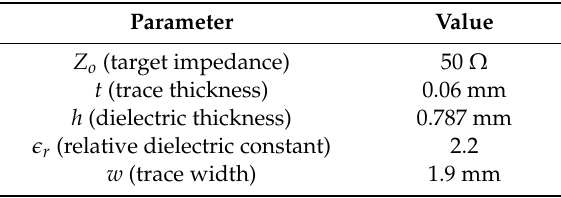
Table 1. TL dimensions and